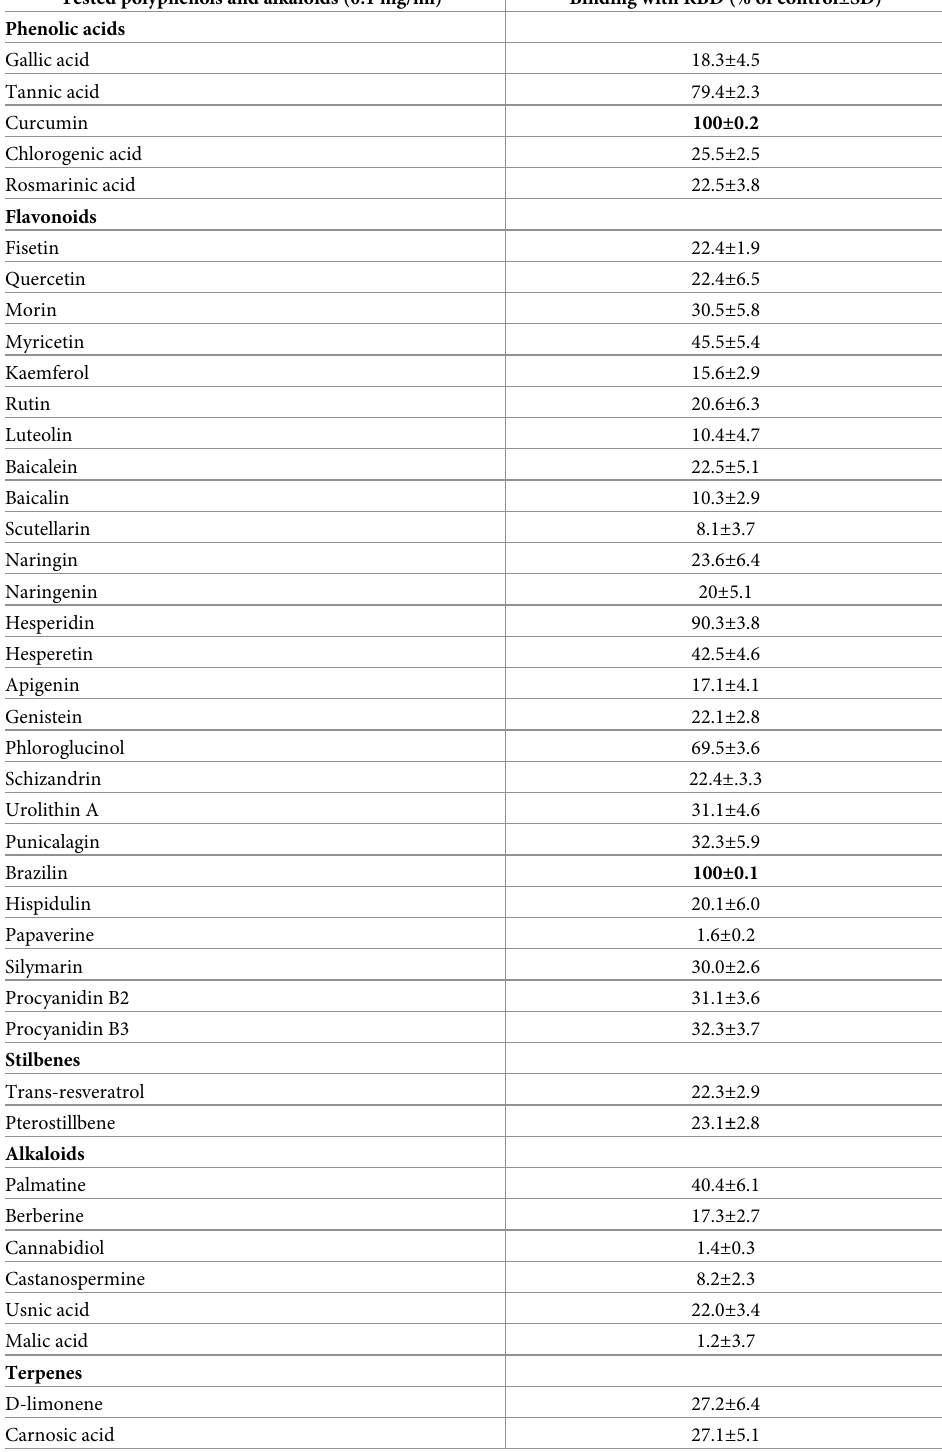
Table 1. Binding of various classes of phenolic compounds with RBD of